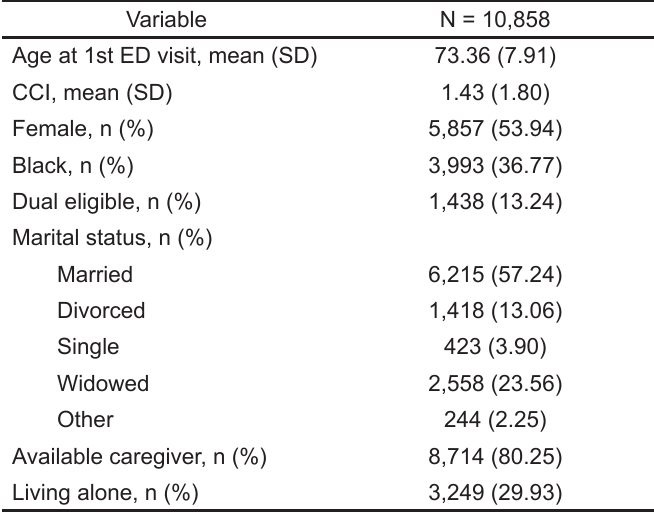
Table 1. Participant characteristics at first ED emergency department visit from